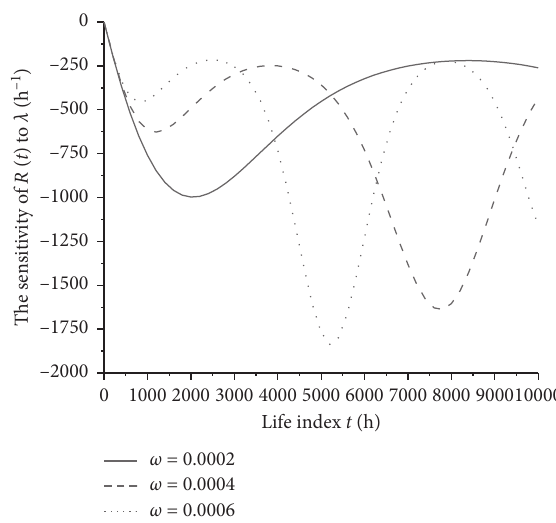
Figure 32: The sensitivity of R ( t ) to λ ( ω � 0.0002/0.0004/0.0006).